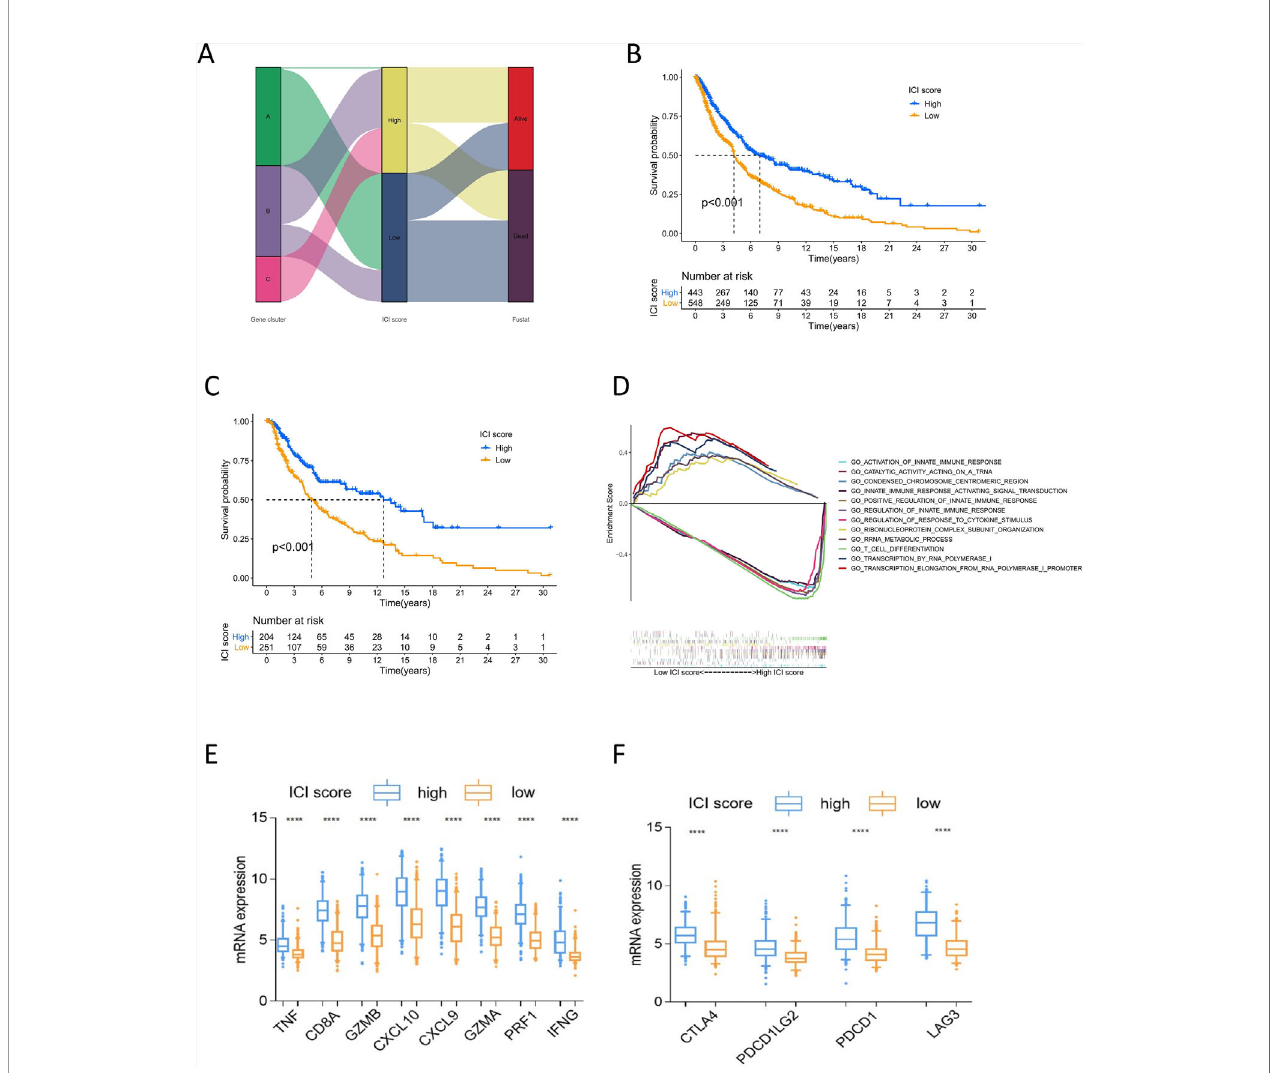
FIGURE 3 | Analysis of ICI score. (A) Alluvial diagram of ICI scores groups distribution in different gene cluster, and survival outcomes. (B) Kaplan-Meier curves of overall survival for high and low ICI score cluster in all sample. Log rank test P <0.001. (C) Kaplan-Meier curves of overall survival for high and low ICI score cluster in TCGA cohort. Log rank test P <0.001. (D) GSEA of high and low ICI score groups for all melanoma samples. (E) The box plot of immune activity related signature genes expression (CXCL9, CXCL10, TNF, IFNG, CD8A, GZMA, GZMB, PRF1) in high and low ICI score, ****P<0.0001. (F) The box plot of immune checkpoint signature genes expression (CTLA4, PDCD1, PDCD1LG2, LAG3) in high and low ICI score,